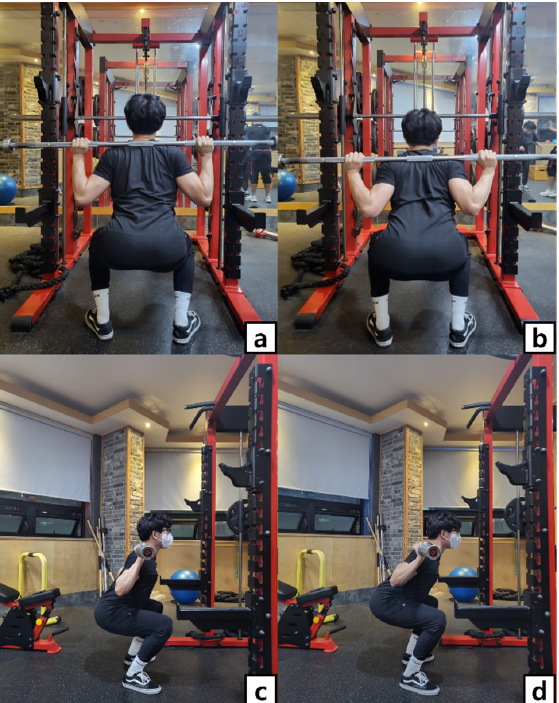
Figure 1. Bar positioning during barbell squat. ( a ) posterior view of HBBS, ( b ) posterior view of LBBS, ( c ) lateral view of HBBS, ( d ) lateral view of LBBS.